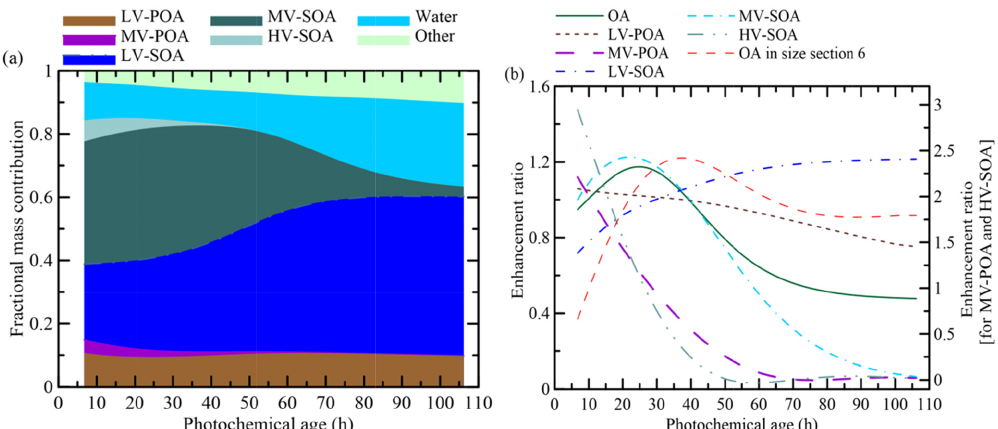
Figure 8. Evolution of the key model species determining the composition of BB aerosol in the CHIMERE simulation for the bb_vbs scenario: (a) fractional contributions of the model species to the mass columnar concentration of BB aerosol; (b) the normalized EnRs of columnar concentrations of organic species in the particulate phase in the simulations for the bb_vbs scenario with respect to the OA concentration in the simulations for the bb_trc scenario, along with similar enhancement ratios for the total columnar OA concentration and OA concentration in the sixth bin (310–630nm) of the particle size distribution in CHIMERE. Note that the EnRs for MV-POA and HV-SOA are presented using the right ordinate